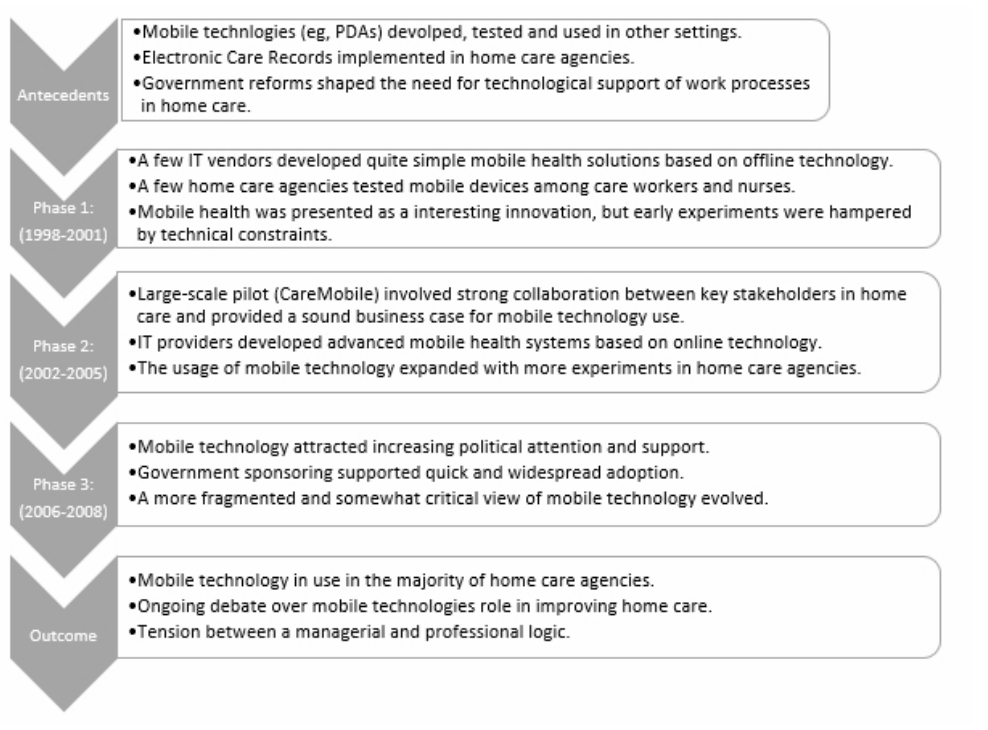
Figure 1. Implementation of mobile health in the Danish home care